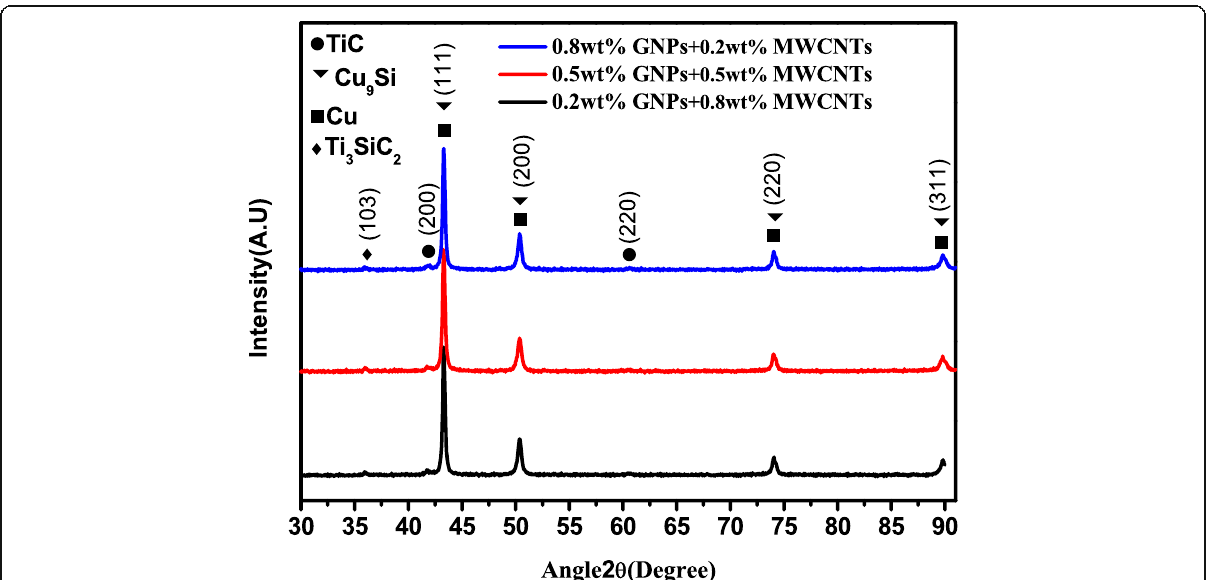
Fig. 8 XRD patterns of sintered nanocomposites: Nanocomposites with 0.8 wt% graphenes and 0.2 wt% MWCNTs, nanocomposites with 0.5 wt% graphenes and 0.5 wt% MWCNTs, and nanocomposites with 0.2 wt% graphenes and 0.8 wt%